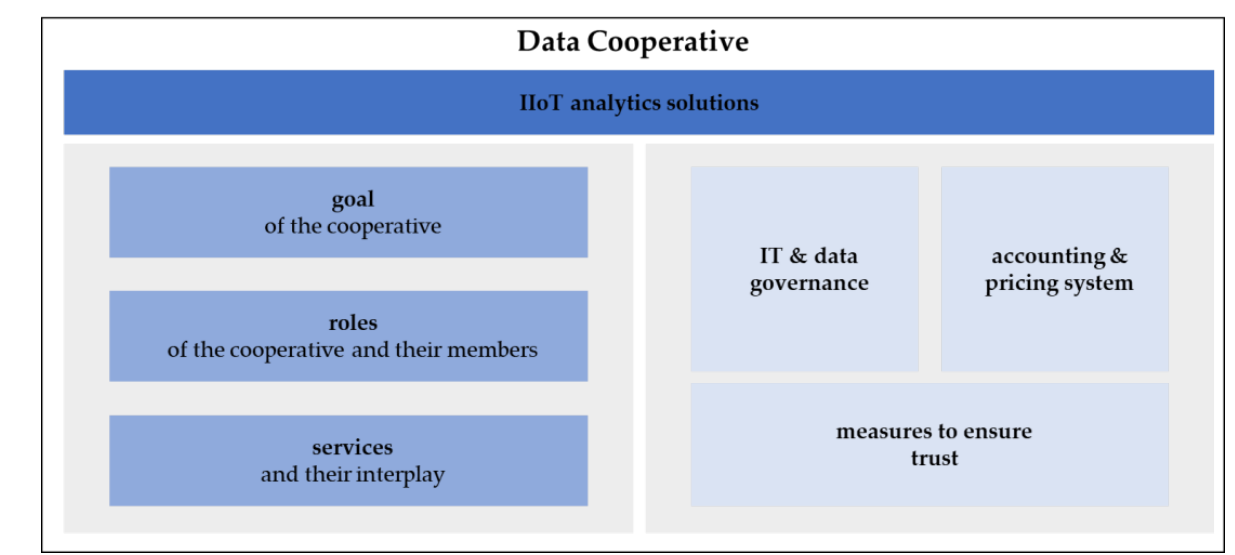
Figure 5. Concept of a data cooperative and its building blocks.